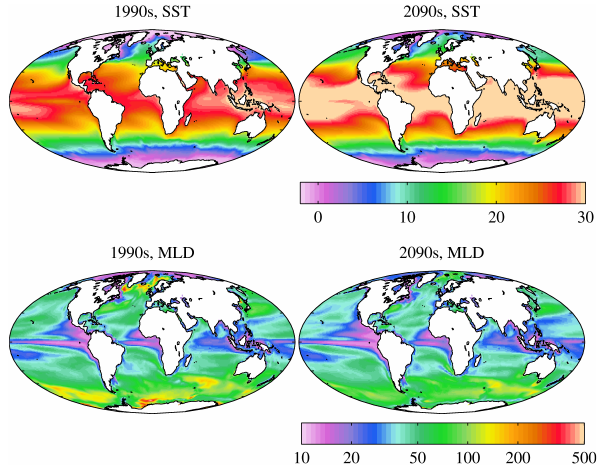
Fig. 9. Annual average 1990s (left) and 2090s (right) sea surface Fig.8. Annualaverage1990s( left )and2090s ( right )seasurfacetemperature( top )andmixedlayerdepth( bottom ). Temperaturein ◦ C,mixedlayerdepthinm(notelogarithmicscale). temperature (top) and mixed layer depth (bottom). Temperature in ◦ C, mixed layer depth in m (note logarithmic